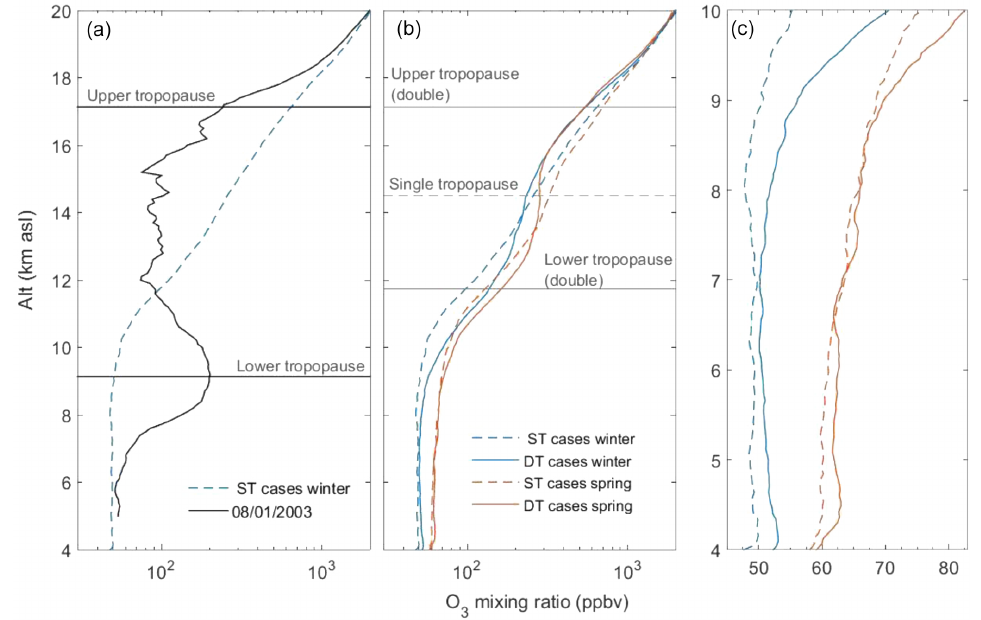
Figure 14. (a) Ozone mixing ratio profile on 8 January 2003 (black line) and winter averaged ozone mixing ratio profile computed in the presence of single tropopause above TMF (blue dashed line). The horizontal solid black lines depict the altitude of the lower and upper tropopauses on 8 June 2013. (b) Winter- and spring-averaged (cyan and red, respectively) ozone mixing ratio profiles computed in the presence of a double tropopause (DT, solid curves) and single tropopause (ST, dashed curves). The horizontal solid grey lines depict the average altitude of the lower and upper tropopauses when a double tropopause was identified. The horizontal dashed grey line corresponds to the average altitude of the tropopause when a single tropopause was identified. (c) Same as panel (b) but zoomed on the tropospheric part of the profiles